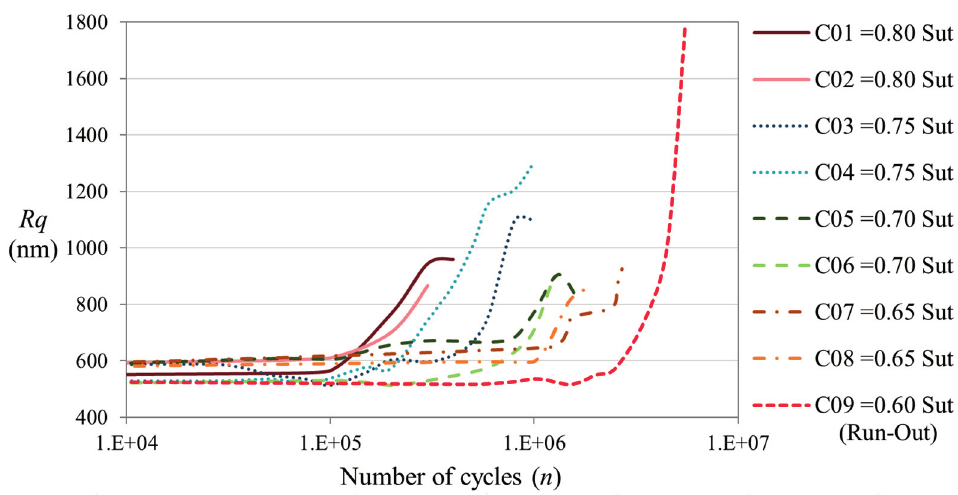
Figure 7. Evolution of the surface roughness magnitude quantified by the parameter Rq during the VALs.